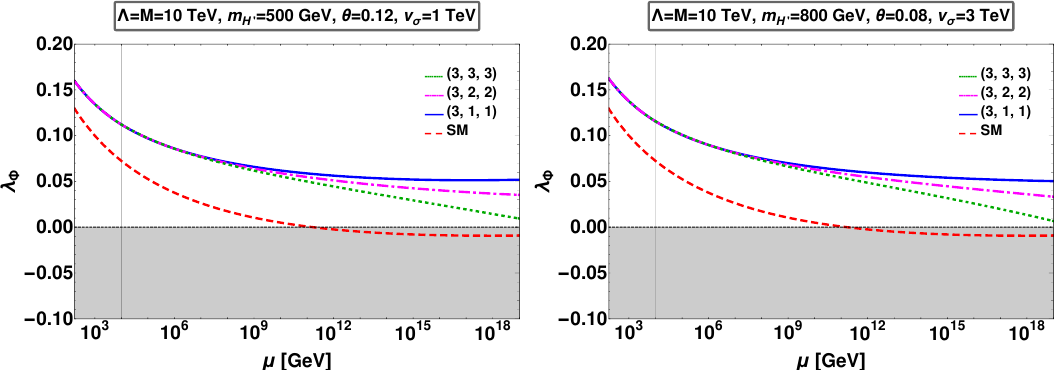
Figure 4 . Comparing the evolution of the quartic Higgs self-coupling λ Φ in the SM (red dashed) with the majoron inverse seesaw mechanism: the minimal (3,1,1) is denoted in solid (blue), (3,2,2) is dot-dashed (magenta) and (3,3,3) is dotted (green). Left panel is for v is for v = 3 TeV. See text for details. . σ